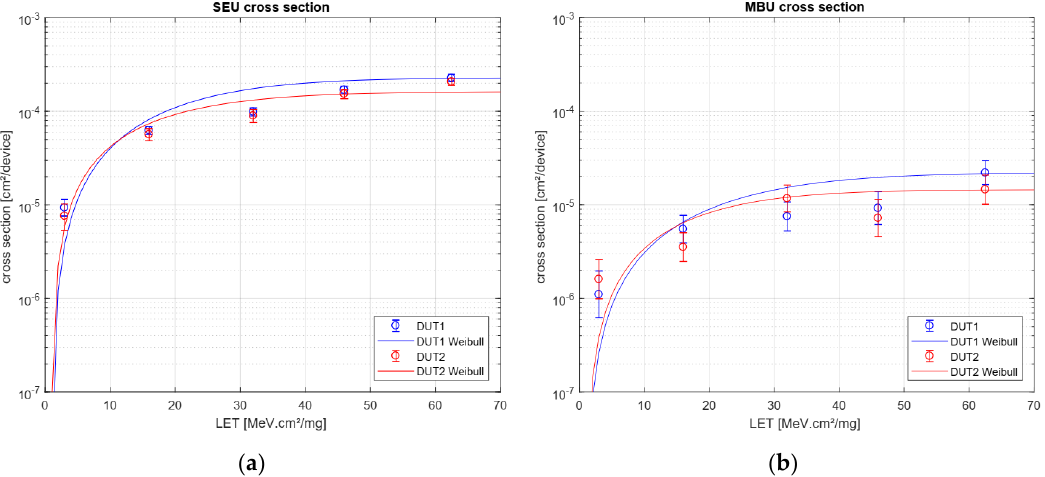
Figure 9. Single event upsets (SEU) cross section ( a ) SEU and ( b ) multiple bit upsets (MBU) cross section for both DUTs with a corresponding Weibull fitting curve (W = 29.43, S = 1.63).